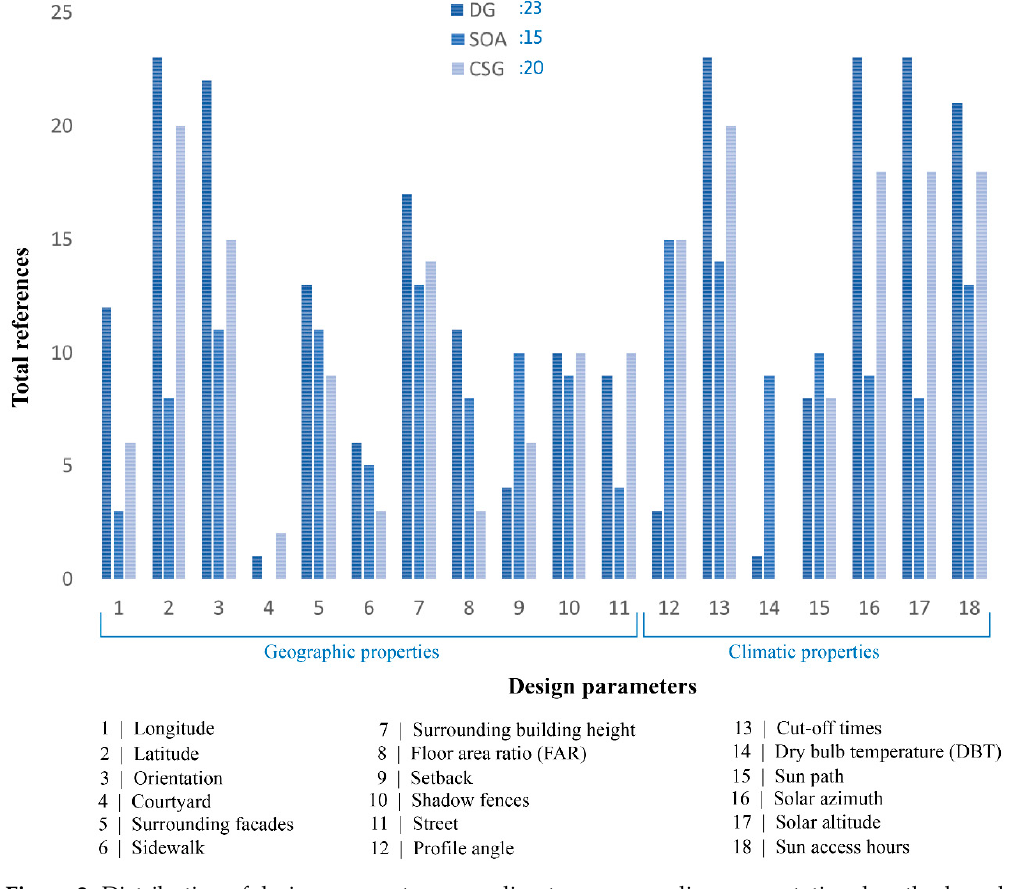
Figure 2. Distribution of design parameters according to corresponding computational methods and selected references. selected